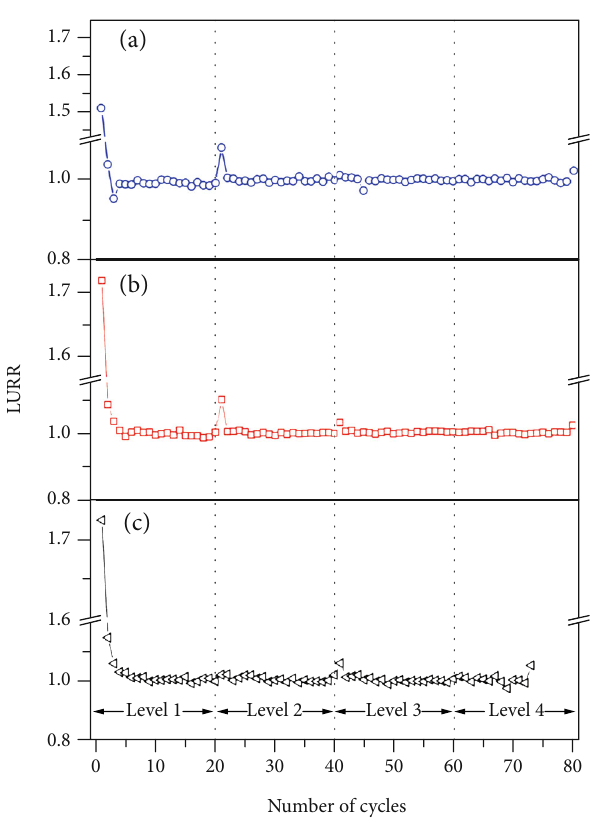
Figure 12: Evolution of LURR versus number of cycles at di ff erent loading frequencies: (a) 0.1Hz; (b) 0.2Hz; (c)